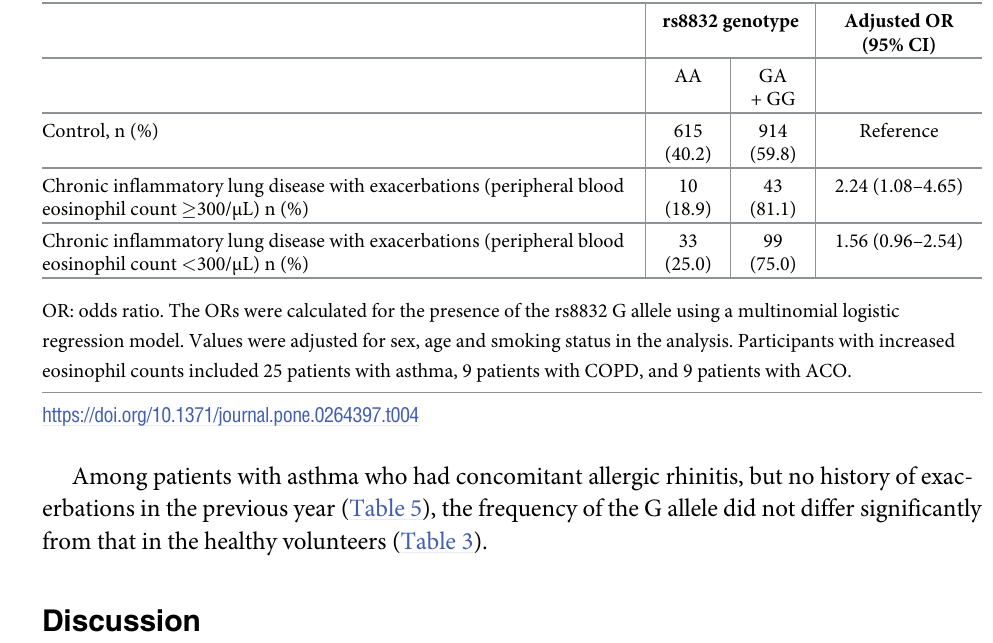
Table 4. Association between the IL4RA polymorphism and chronic inflammatory lung disease with eosinophilia.